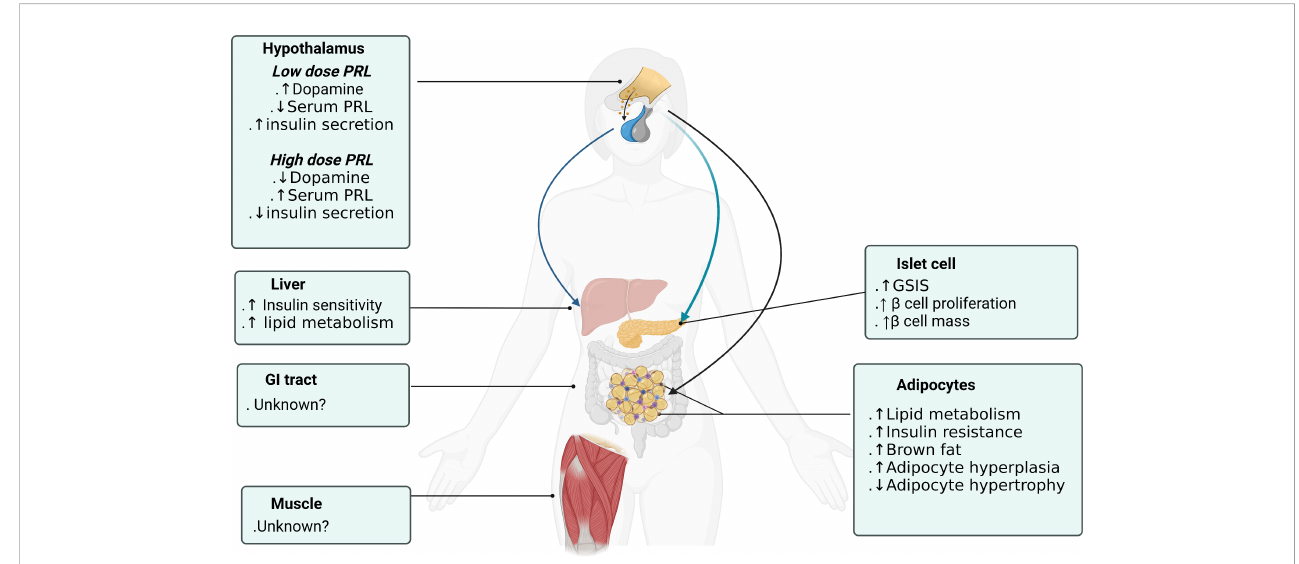
FIGURE 2 Prolactin actions on different organs to promote metabolic homeostasis. Figure created using BioRender